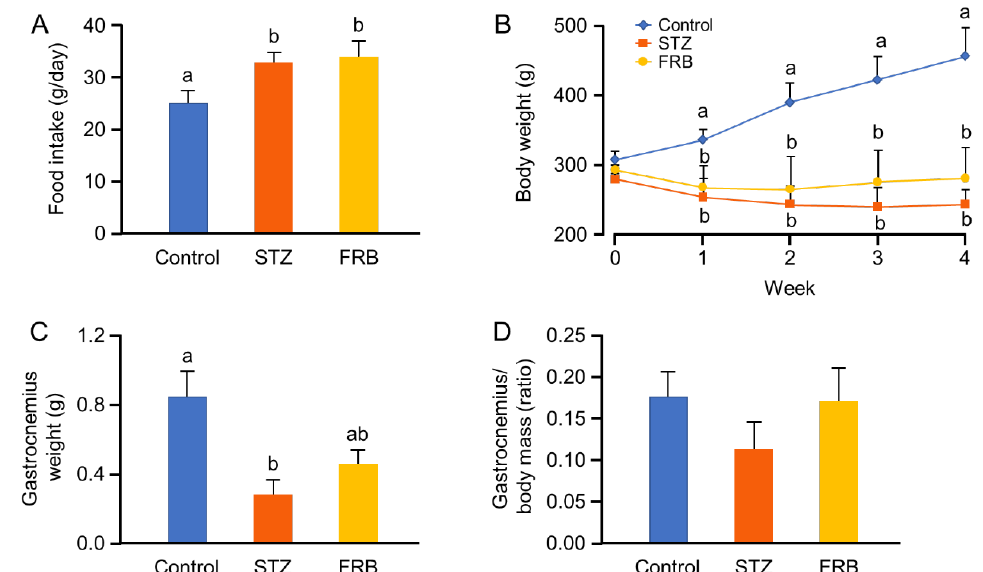
Figure 1. STZ-induced diabetes decreases body weight of rats. ( A ) The average food intake per day; ( B ) body weight changes (analyzed using repeated measures ANOVA); ( C ) gastrocnemius muscle weight; and ( D ) Normalized gastrocnemius weight to body mass. Data are shown as the means + SEM. Significance ( p < 0.05, n = 5 – 6) among groups is denoted by different letters (a, b).